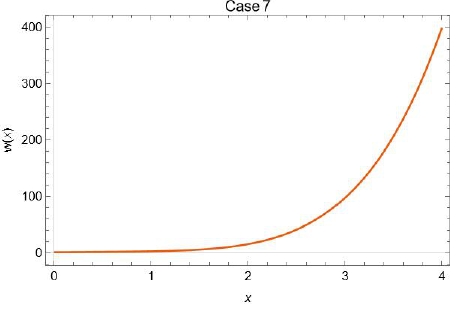
Figure 5. We let a 0 = 1, a 1 = 1, a 2 = 1, α = 1